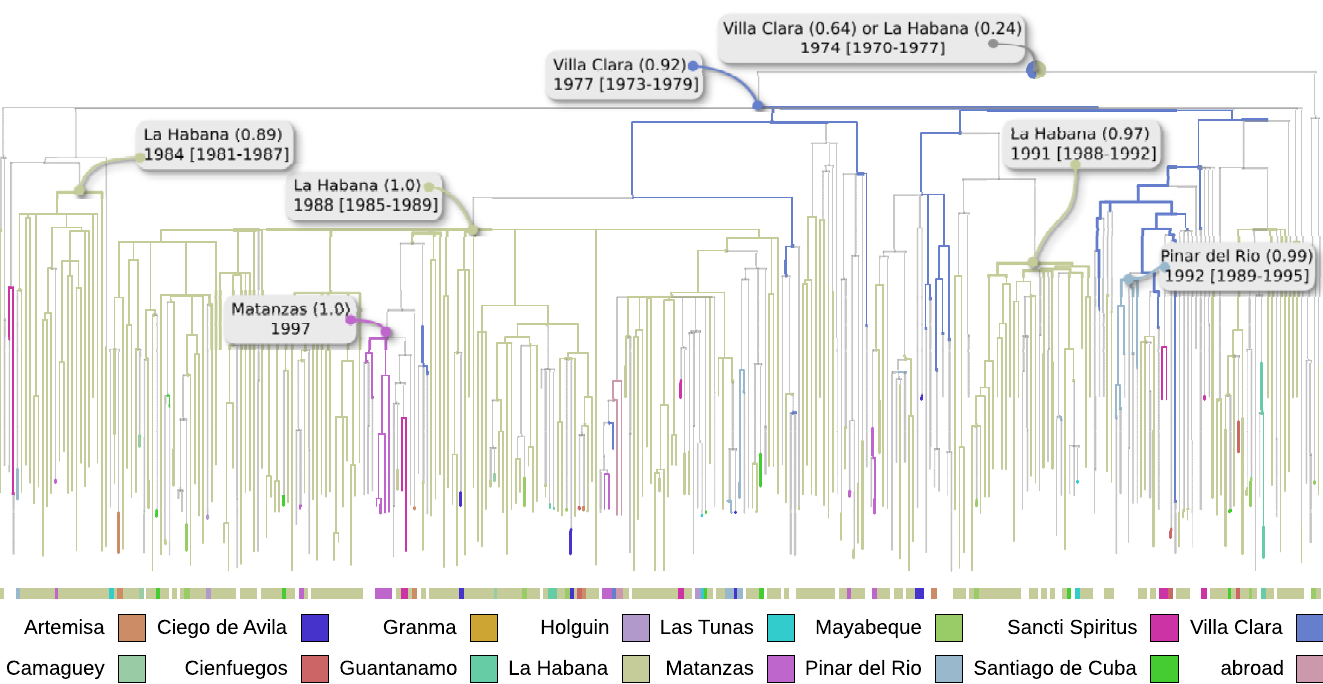
Fig 2. Phylogeography (province level) of CRF19. ACR and visualisation are done with PastML [18] (MPPA+F81). Branches are coloured by provinces (colour code is explained below), gray thinner branches correspond to a province change. The root is unresolved between Villa Clara and La Habana. The oldest resolved node and its date are indicated and correspond to Villa Clara (marginal probability 0.92), the dates and marginal probabilities of the main introductions from Villa Clara to La Habana are also marked.